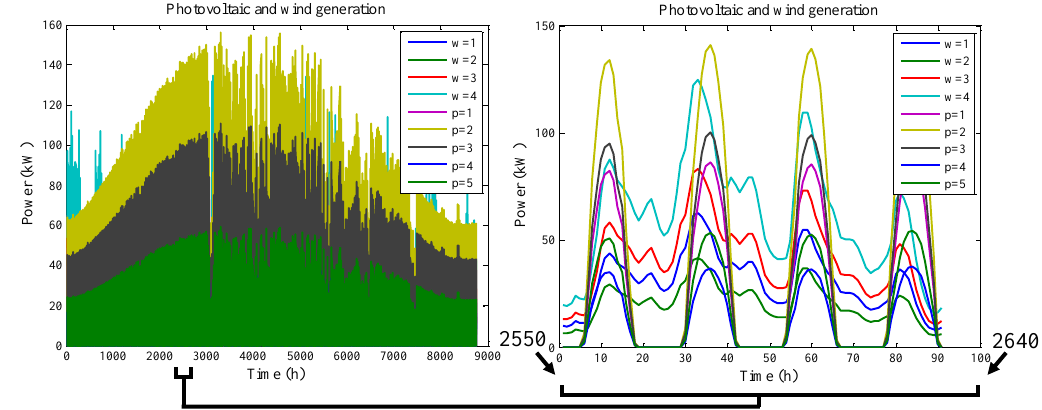
Figure 20. PV and wind power time series.